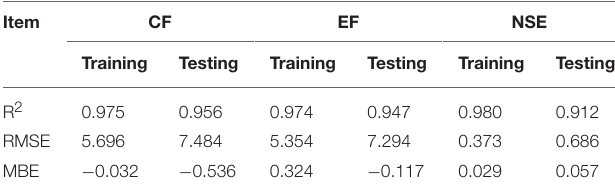
TABLE 1 | Statistics of ANFIS models for callogenesis frequency (CF), embryogenesis frequency (EF), and number of somatic embryo (NSE) embryo of chrysanthemum (training vs. testing